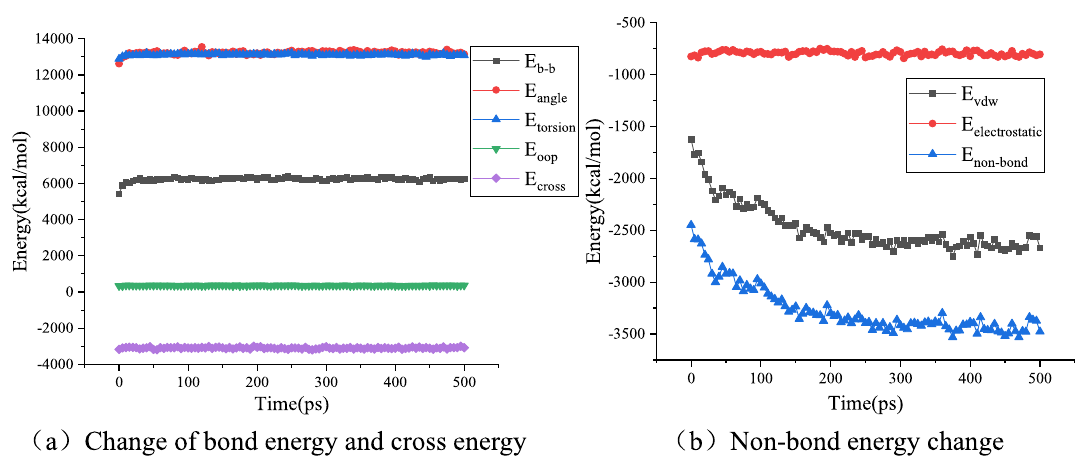
Figure 16. Energy change during ROSL-10 self-healing